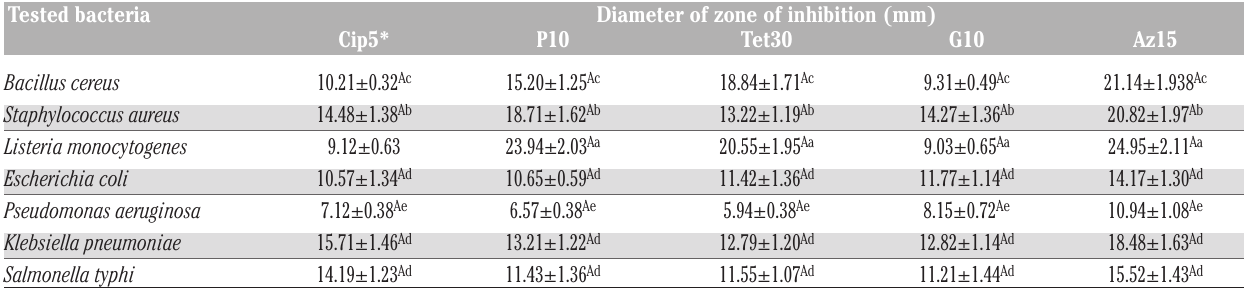
Table 2. Diameter of the zone of inhibition of different bacteria against antibiotic agents. Tested